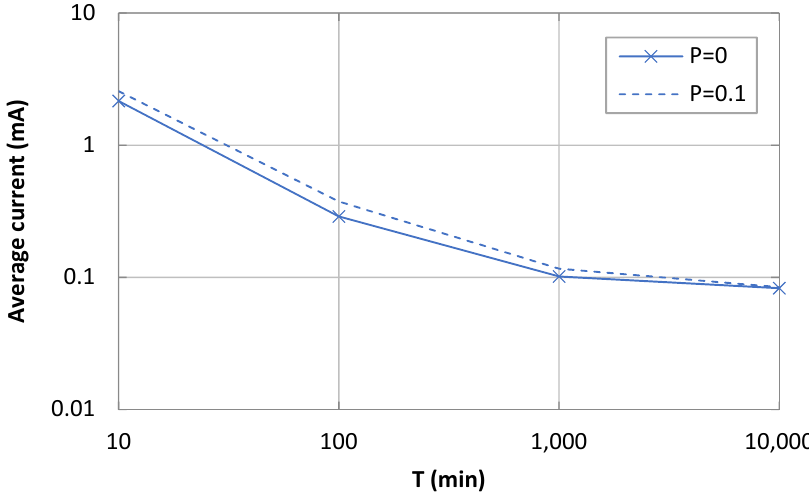
Figure 7. Average current consumption as a function of T .